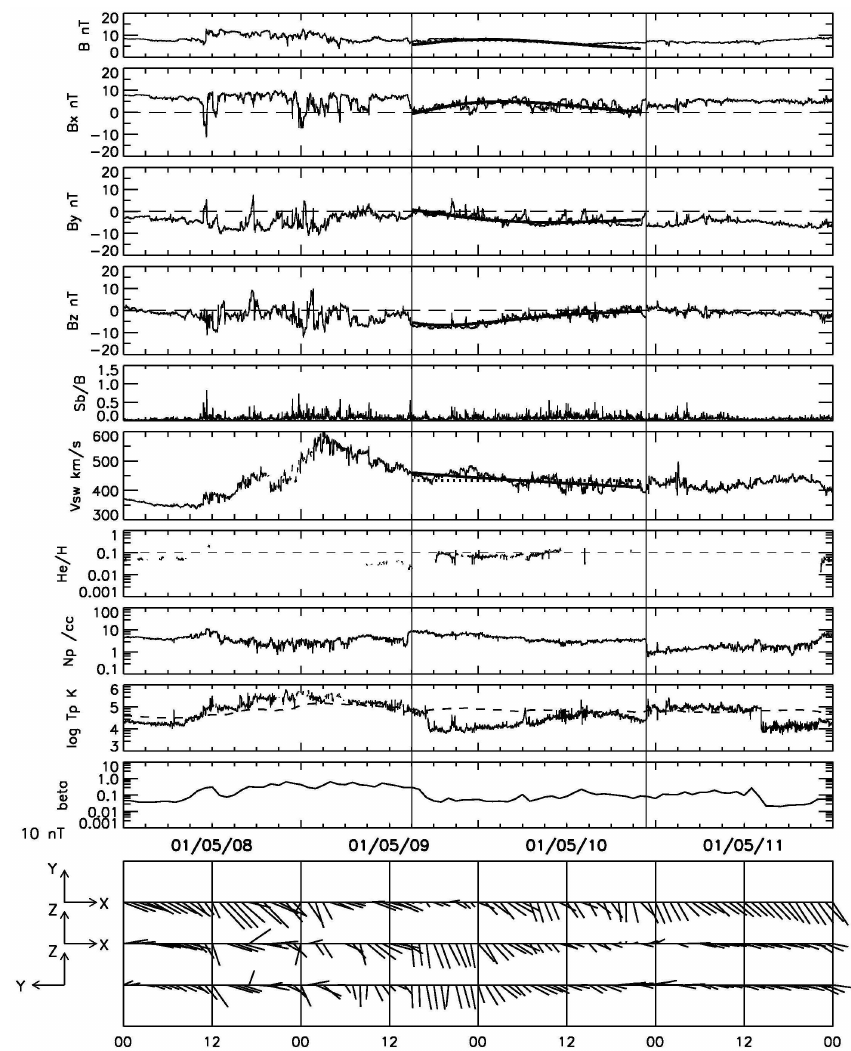
Fig. 6. Results of the fitting with the torus model (solid curve) and with the cylinder model (dotted curve) to the magnetic cloud (MC) encountered on 9 May 2001 (Event No. 14) in the same format as Fig. 4. Note that the fitting results with two models are very close to each other. The bottom three panels show the projected magnetic field vectors.